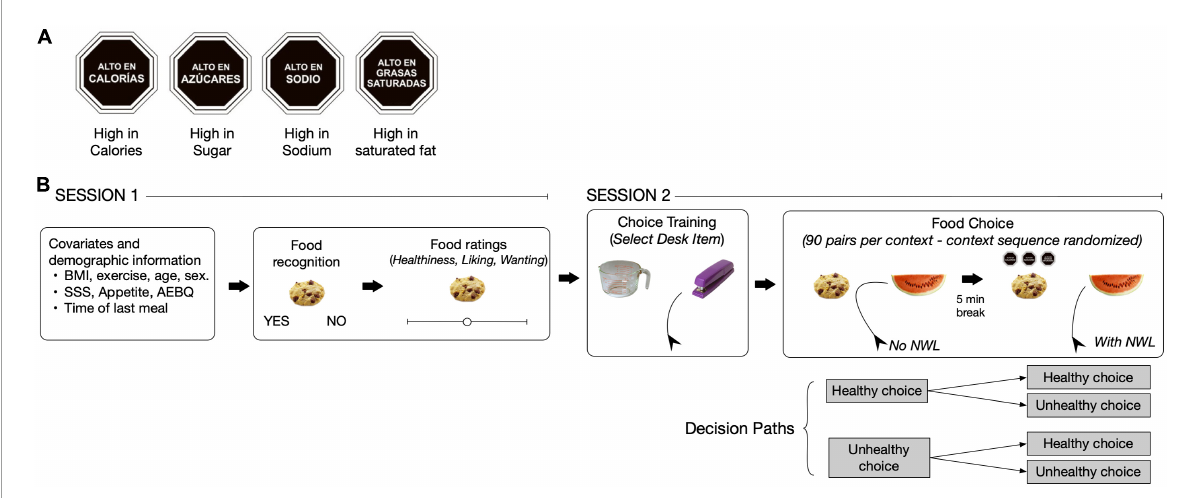
FIGURE1 Nutrient warning labels (NWL) and experimental design. (A) NWL used in the experiment. At the bottom of each label is the English translation from the original Spanish. (B) The experiment had two sessions. Demographic information and subjective ratings were collected in the first session and the food choice tasks were conducted in the second session.